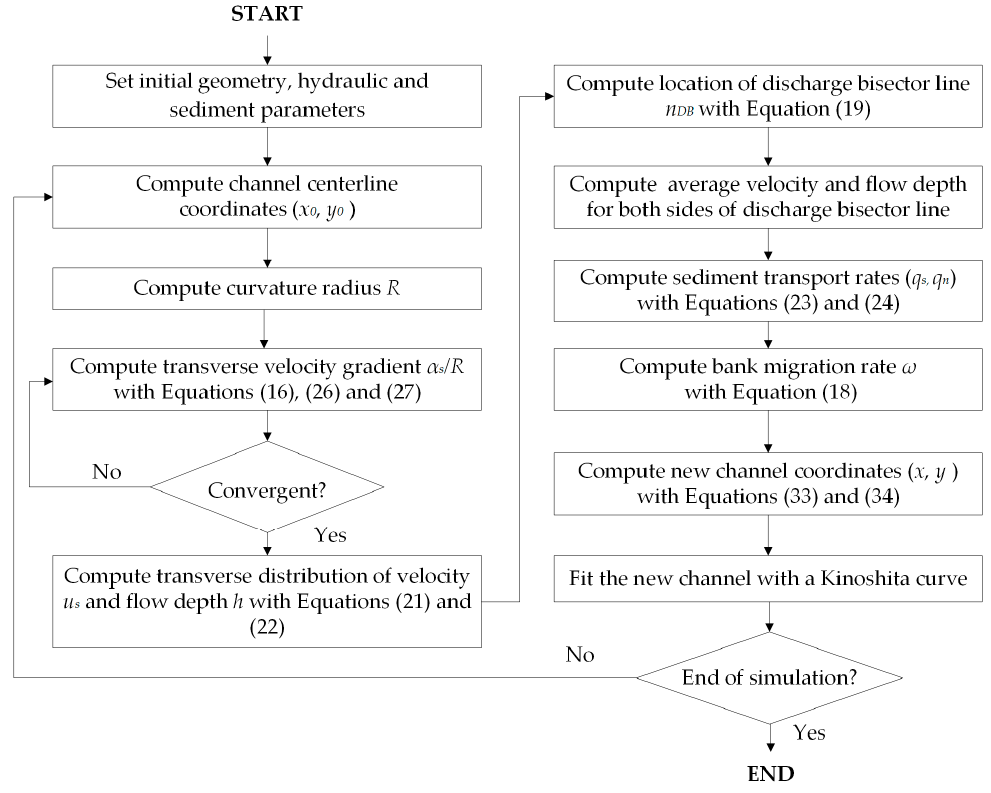
Figure 1. Flow chart of performing a numerical simulation with the nonlinear model.